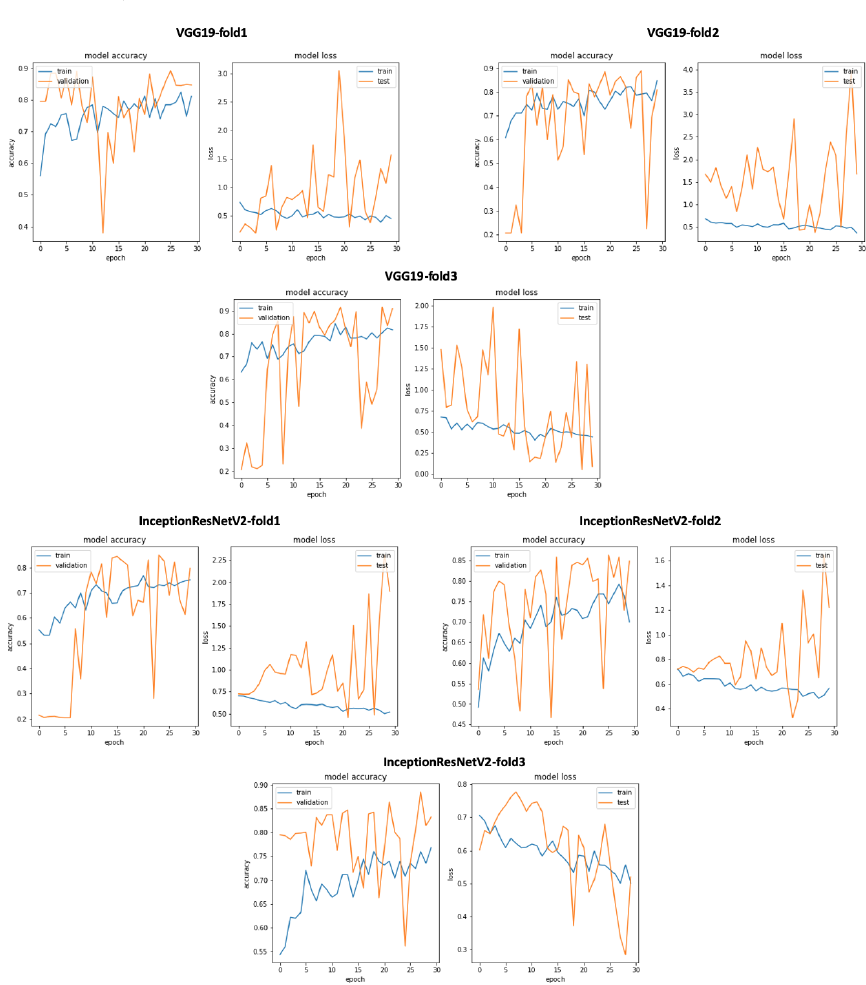
Figure 19. VGG19 and InceptionResNetV2 training and validation curves using raw dataset.